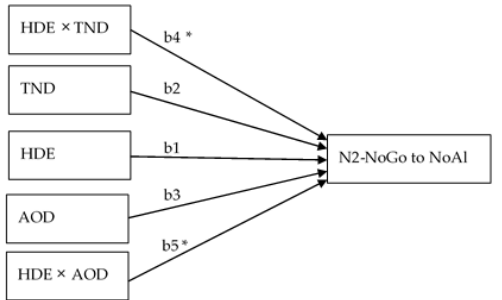
Figure 4. Diagram of the moderation model (model 2 from process): The two moderator variables considered in the model (total number of drinks in the last 180 days (TND) and age of onset of drinking (AOD)) interacted with the predictor variable (BDE) to explain the relation with the dependent variable (N2 NoGo to NoAl stimuli amplitude). BDE: binge drinking episodes in the last 180 days; TND: total number of drinks in the last 180 days; AOD: age of onset of drinking; b: regression coe ffi cients; * p <